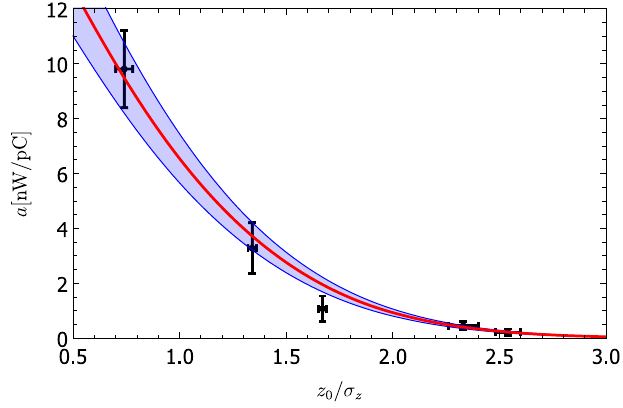
FIG. 14. Linear part of the SPR signal a shown in Fig. 13 for the five different applied distances (values from Table III).